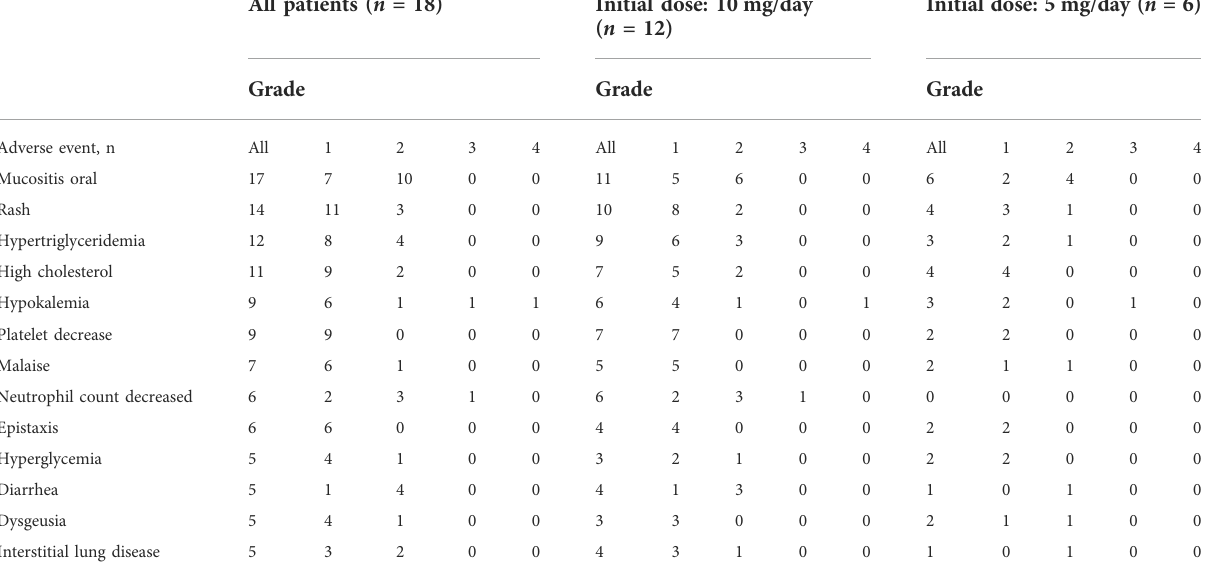
TABLE 2 Most common and grade S 3 adverse events.